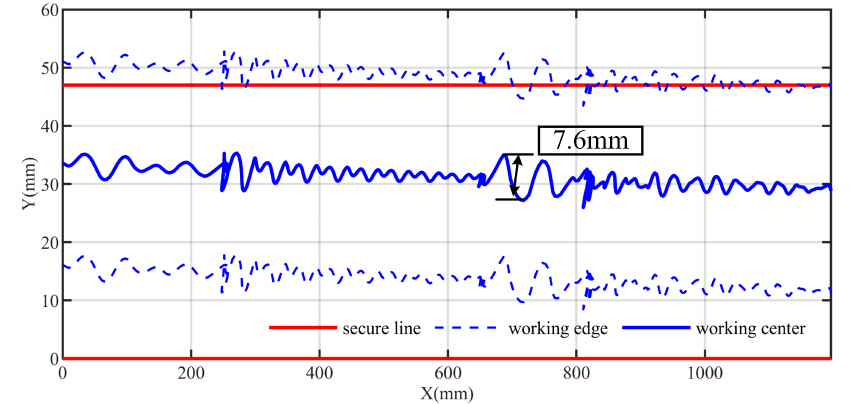
Figure 23. End slit crossing